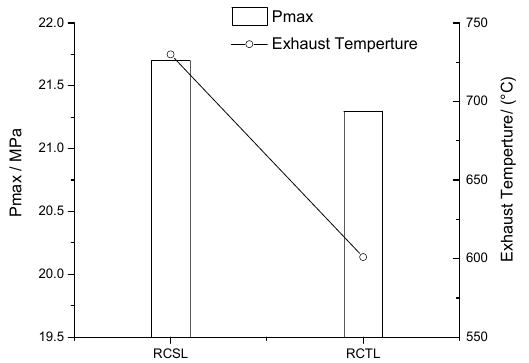
Figure 12. Cylinder pressure for two combustion chambers at BMEP2.6 MPa load.